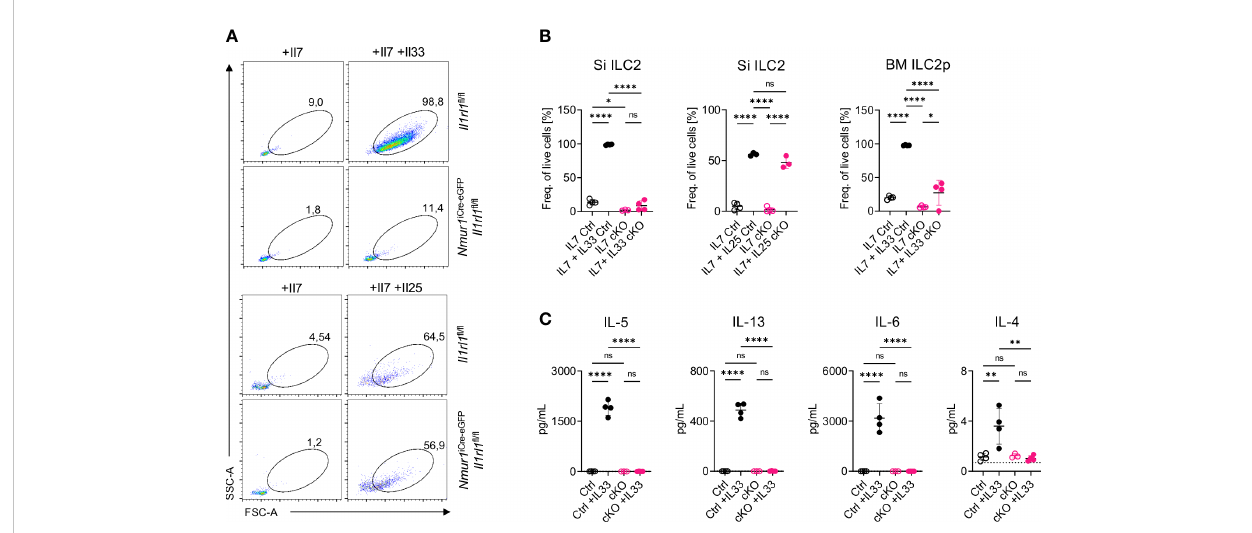
FIGURE 2 ILC2 of Nmur1 iCre-eGFP Il1rl1 fl ox/ fl ox mice are unresponsive to IL-33. (A) , Flow cytometric plots of small intestine ILC2s from Il1rl1 fl ox/ fl ox and Nmur1 iCre-eGFP Il1rl1 fl ox/ fl ox mice after stimulation with IL-7, IL-7 and IL-33 or IL-7 and IL-25. ILC2s were gated on live CD45 + Lin - (CD3, CD5, CD19, Ly6G, Fcer1), CD127 + and KLRG1 + . (B) , Quanti fi cation of ILC2 activation from (A) and bone marrow ILC2s of Il1rl1 fl ox/ fl ox (Ctrl) and Nmur1 iCre-eGFP Il1rl1 fl ox/ fl ox (cKO) mice after a three day culture with cytokines IL-7 or IL-7, IL-33 or IL-7, IL-25. (C) , Concentration of the indicated cytokine as determined in the cell culture supernatant 3 days after stimulation as in (A, B) . For (B, C) : Each symbol represents data from one mouse, data are representative of two experiments with four mice per group. Mean +/- SD, One-way ANOVA with multiple comparison. ns, not signi fi cant, *p < 0.05, **p < 0.01, ****p <